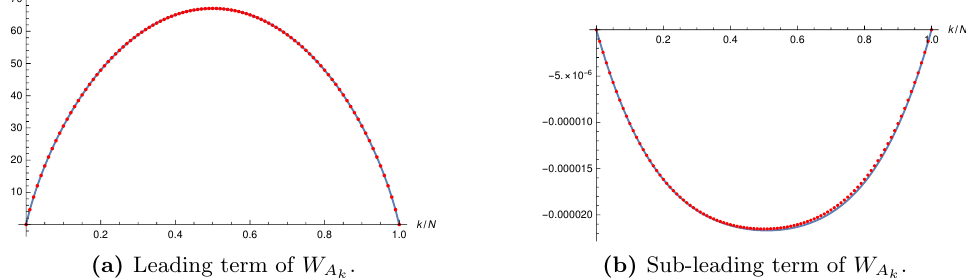
=W LO ) while A k A k